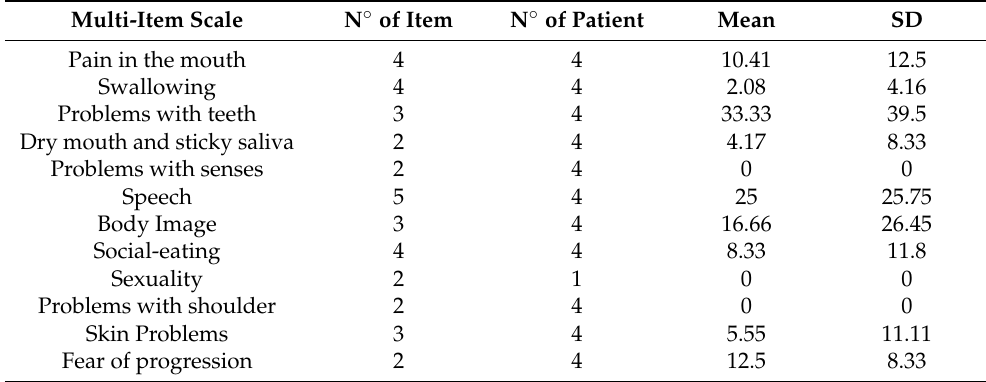
Table 4. Multi-item score distributions for EORTC QLQ-H&N 43.